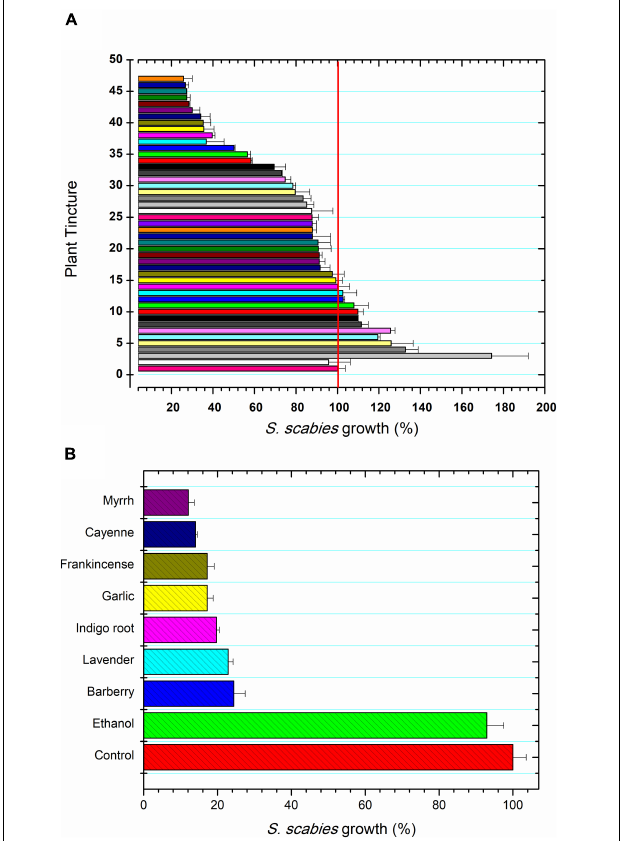
FIGURE 1 | Plant extracts for control of S. scabies growth. (A) S. scabies growth in the presence of 45 plant ethanolic tinctures for 16 h at 30 ◦ C and 250 rpm as described in the section “Materials and Methods.” The samples tested were: 1, control; 2, ethanol treatment; 3, cedar ( Thuja occidentalis ); 4, hawthorne leaf ( Cratageus oxycanthus ); 5, Madagascar periwinkle ( Catharanthus roseus ); 6, St. John’s wart ( Hypericum perforatum ); 7, bearberry ( Hypericum perforatum ); 8, cinnamon ( Cinamomum zeylandicum ); 9, oregano ( Origanum vulgare ); 10, heal-all ( Prunella vulgaris ); 11, onion ( Allium cepa ); 12, burdock ( Arctium lappa ); 13, grape seed ( Vitus vinerfa ), 14, peppermint ( Methna X piperita ); 15, reishi mushroom ( Ganoderma lucidum );